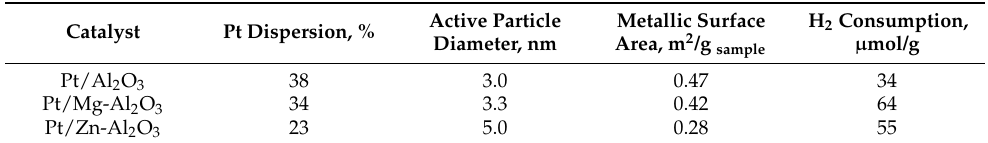
Table 3. TPR and CO pulse chemisorption of the